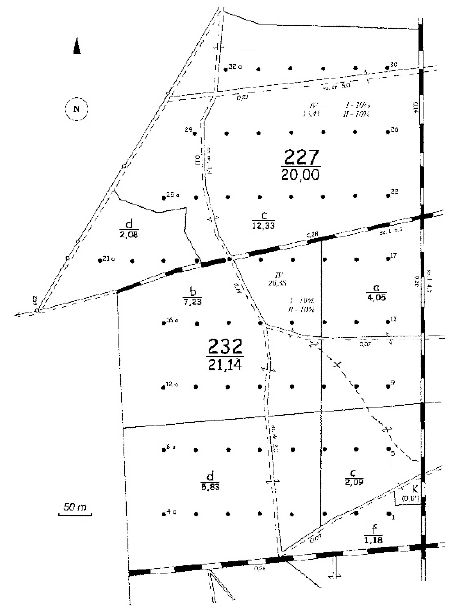
Figure 1. Distribution of permanent circular measurement plots across the forest being sampled and located in the Unieszów Forestry Range.